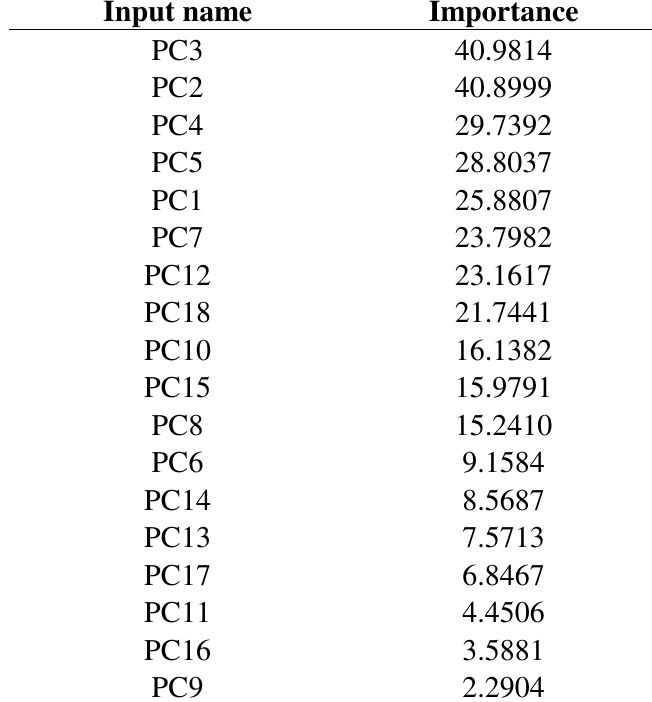
Table 3. Importance of input variables for the 18PC_IR-MS-ANN expert